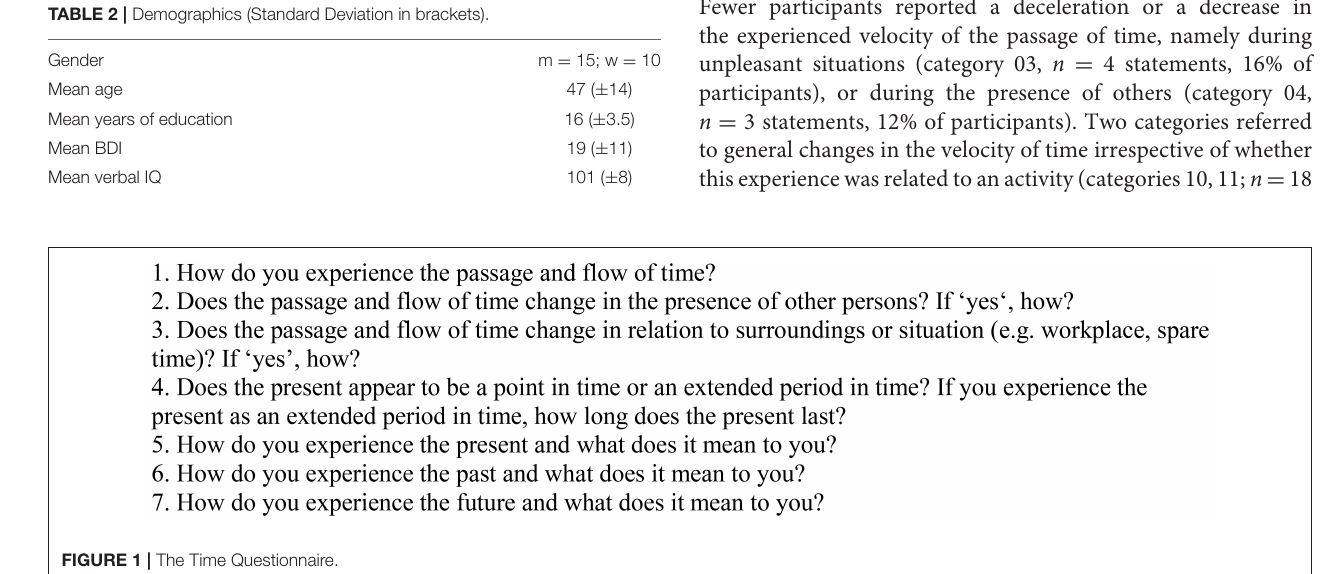
FIGURE 1 | The Time